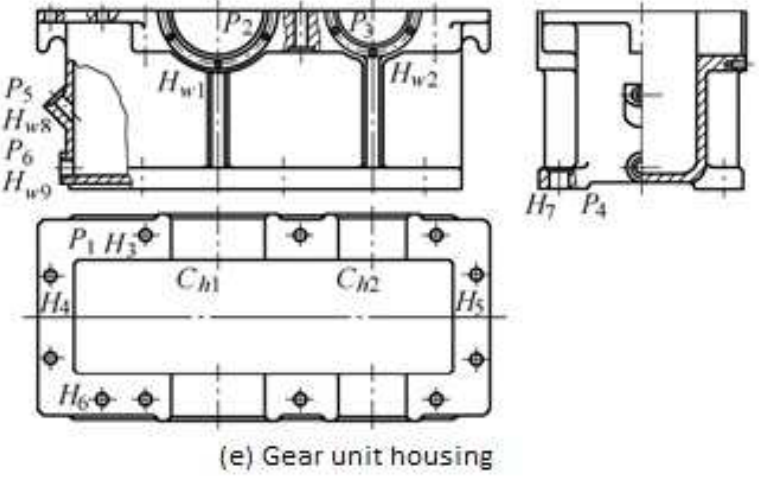
Figure 3. Expression views of several mechanical parts’ functional surfaces